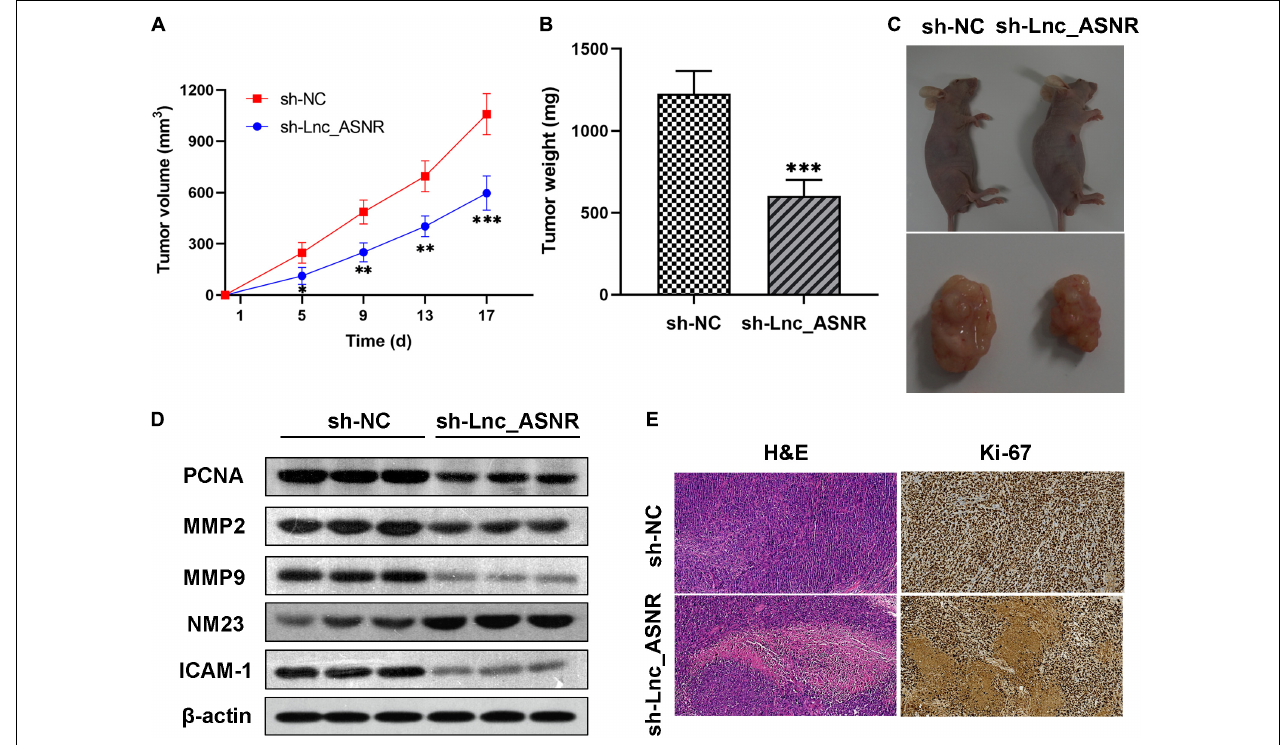
FIGURE 4 | Silenced Lnc_ASNR suppresses the tumorigenesis ability in vivo . (A) The sizes of tumors were measured, and the volume was calculated every 4 days. (B) Tumor weights in different groups were shown. (C) Images of tumors formed from AGS cells in different groups were represented. (D) Related protein expression levels in tumor tissues were investigated via western blot assays. (E) Images of H&E staining and Ki67 immunostaining for nude mice tumor tissues in different groups. Error bars, mean ± SEM. * P < 0.05; ** P < 0.01; *** P < 0.001.